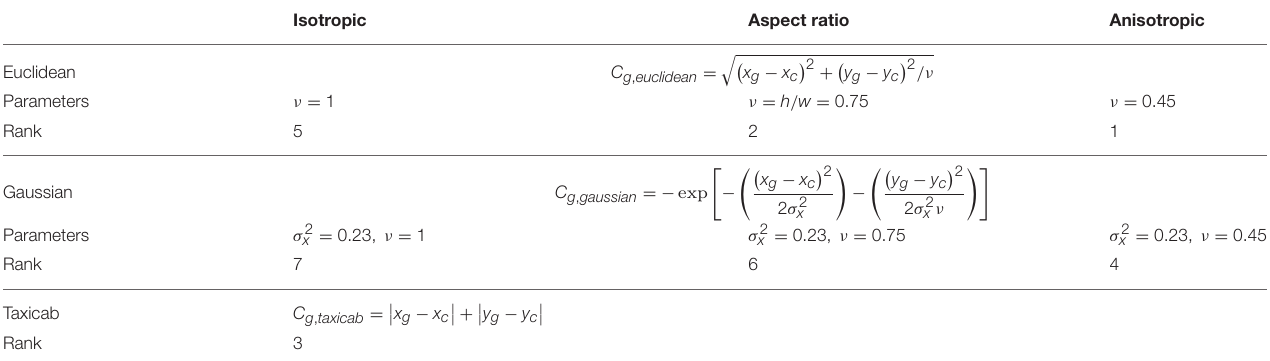
TABLE 1 | Taxonomy of central-bias variables calculated by the GridFix toolbox. Isotropic Aspect ratio Anisotropic